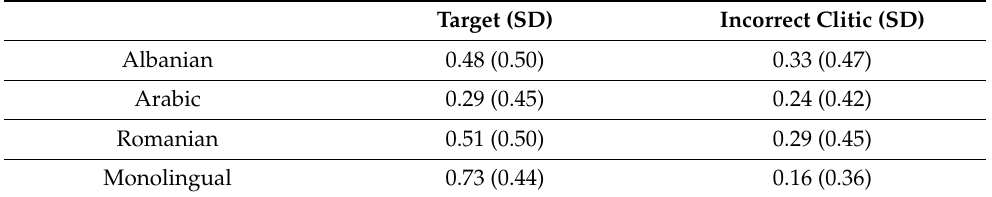
Table 1. Percentage of target clitics and clitics with incorrect features (and standard deviations) produced in a DO clitic production task in Vender et al.